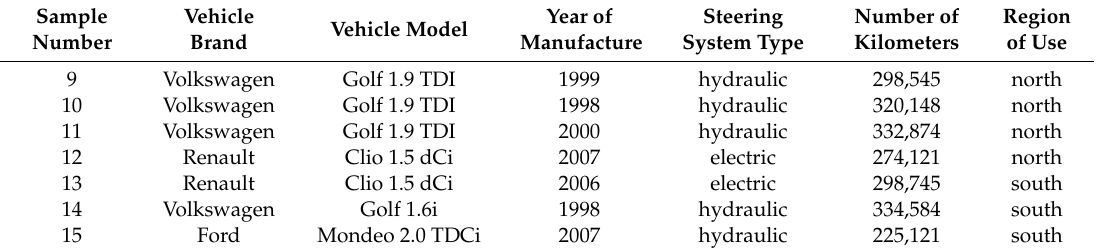
Table 3. The classification of vehicles for testing at temperatures from − 4 ◦ C to − 20 ◦ C.